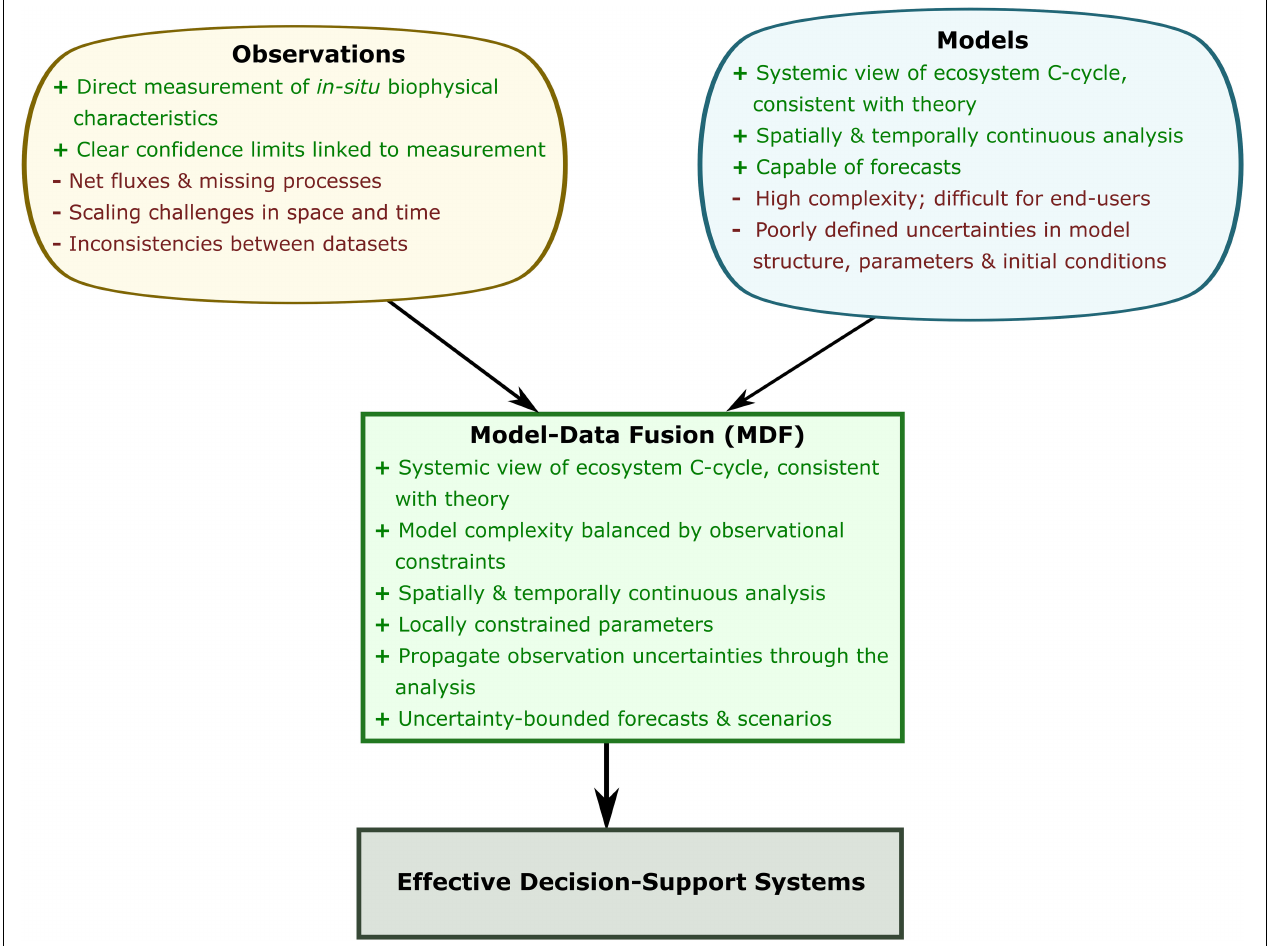
FIGURE 1 | Schematic highlighting the strengths (+) and weaknesses ( − ) of observations and models and how these can be reduced or accounted for to maximise information content through model-data fusion